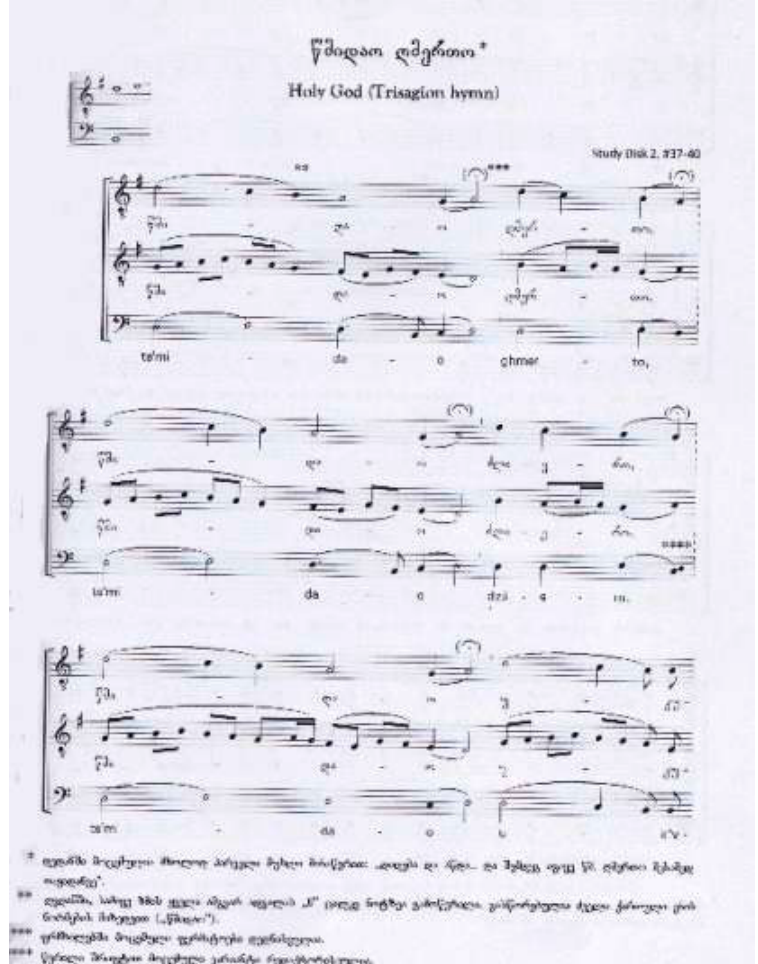
Figure 10. Trisagion; Gelati School (Chkhikvishvili and Razmadze 2010).